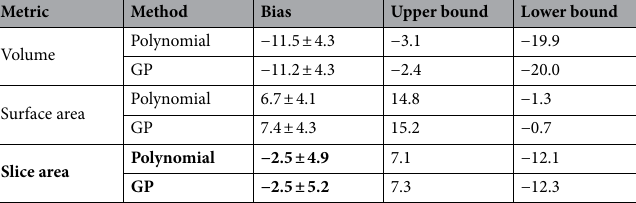
Table 8. Bland–Altman plots statistics for phase selection metric a . a Represented as mean bias ± standard deviation. In bold, the best performing phase selection